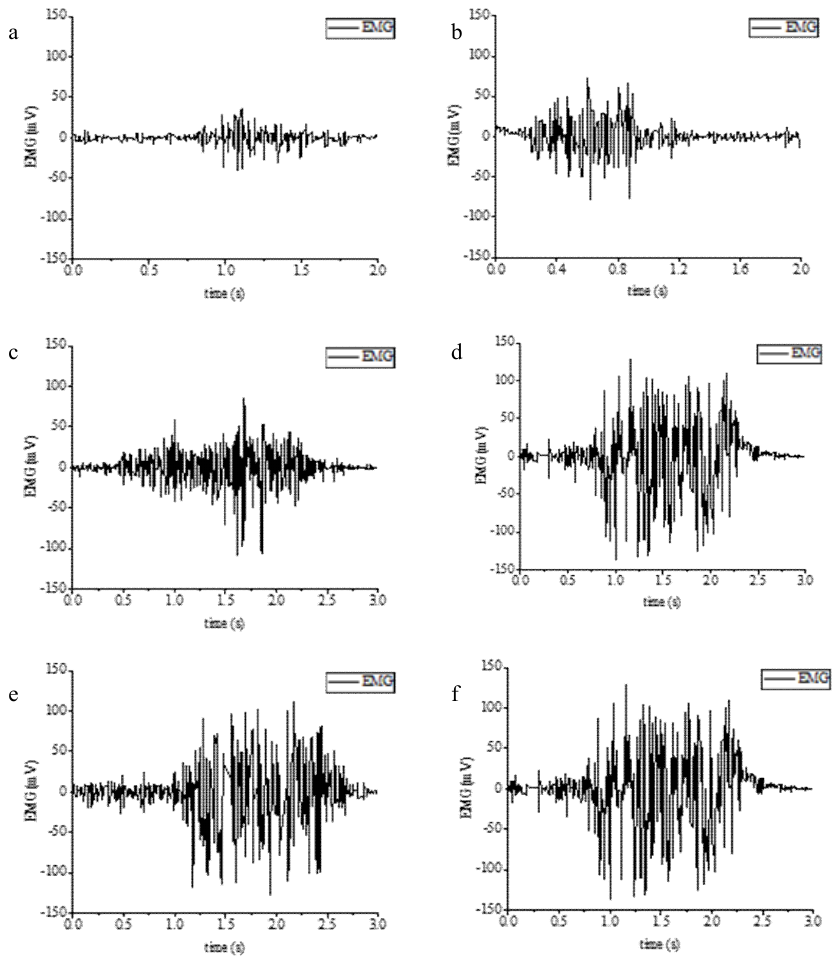
Figure 10. Electromyography under different grip strength. ( a ) Electromyography at 5 kg grip strength. ( b ) Electromyography at 10 kg. ( c ) Electromyography at 15 kg. ( d ) Electromyography at 20 kg. ( e ) Electromyography at 25 kg. ( f ) Electromyography at 30 kg.